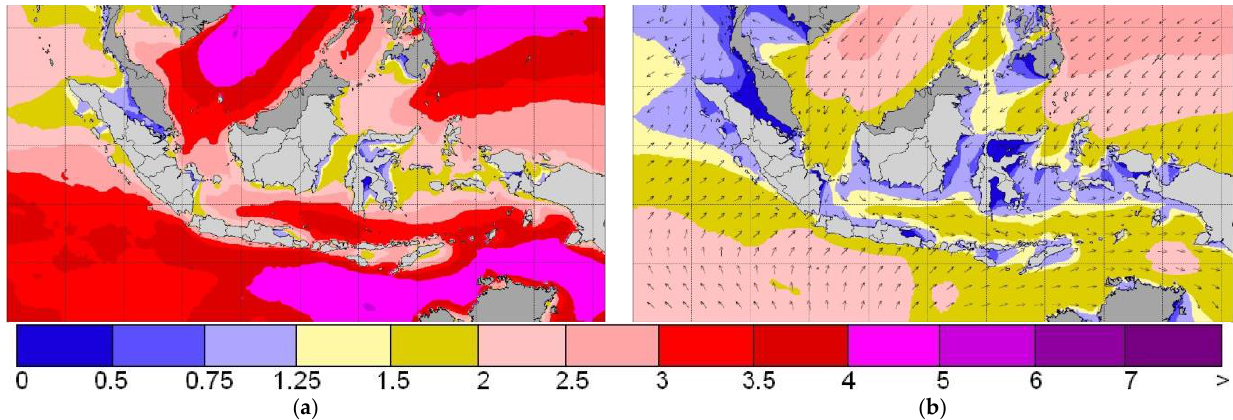
Figure 9. Sample of: ( a ) absolute highest significant wave height map; and ( b ) average significant wave height map in January during period of 2000–2010. The color gradation measures the height in meters [48].